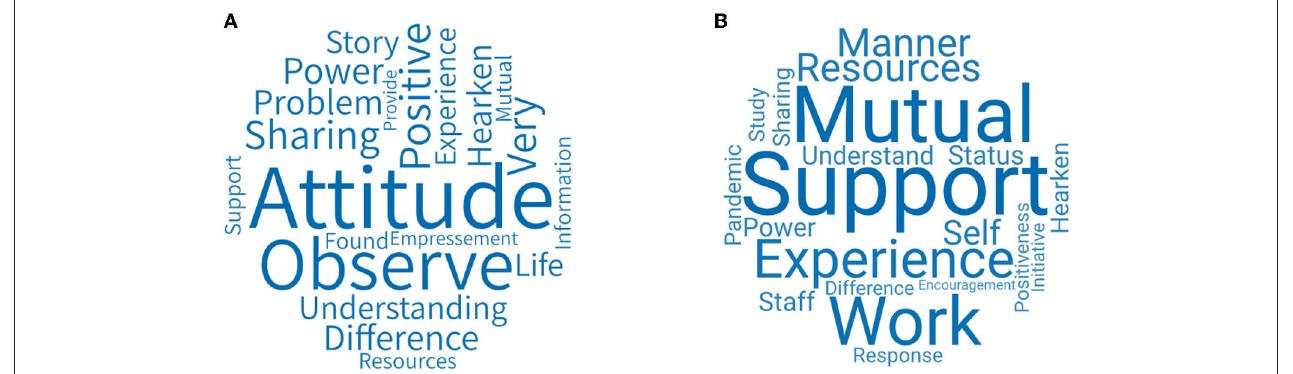
FIGURE 6 | (A) Resources obtained in OESAG considered by group members. (B) Resources obtained in OESAG considered by group leaders.